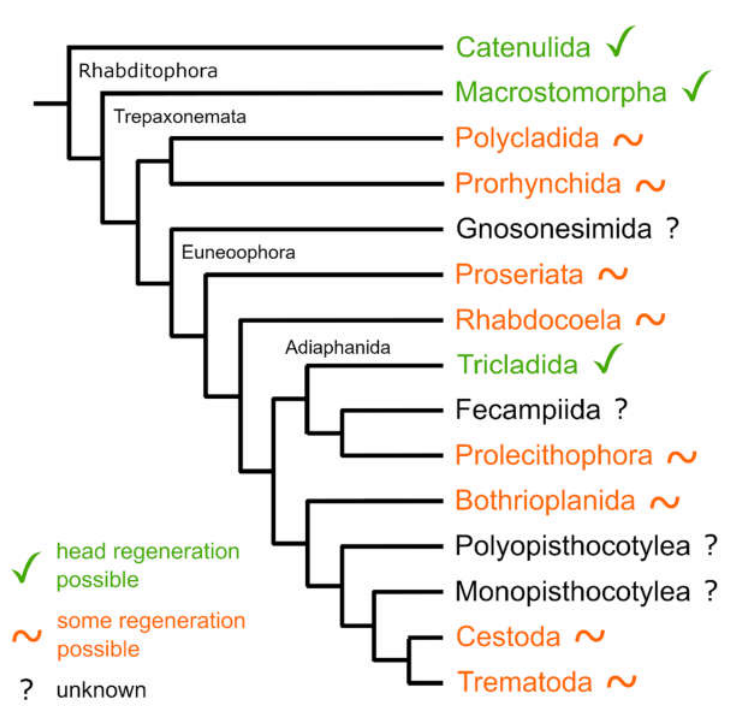
Figure 1. Inter-relationships of higher-level taxa in Platyhelminthes , drawn after [24,26] and [27]. Green colour and check marks indicate that at least some representatives of the taxon are known to completely regenerate a head. Orange colour and tilde indicate that at least some representative of the taxon are known to regenerate some body parts, but never the complete head. Black colour and a question mark indicate that no regeneration studies have been undertaken for the respective taxa. The taxon Prolecithophora is only poorly studied and no model organisms are avail- able. They are tiny (within the millimetre range), mostly drop-shaped free-living flat- worms, which are very common on algae and soft sediments of marine habitats [28–30]. As a member of the Adiaphanida (from the Greek word adiafanis which means opaque), they all have a non-transparent epidermis [19]. Most representatives have a ciliary groove and two pairs of eyes in the anterior body part at the level of the brain. The morphology and location of the pharynx and genital organs vary greatly, but they present an important